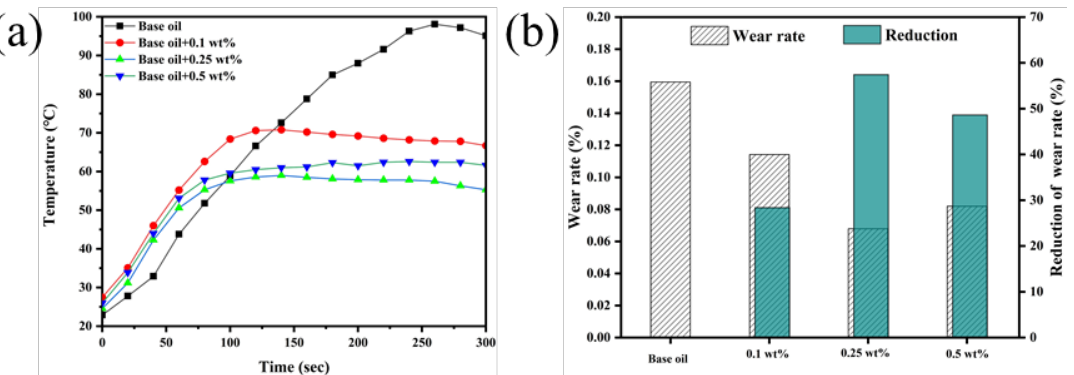
Figure 12. ( a ) Oil temperature change curve and ( b ) wear rate.